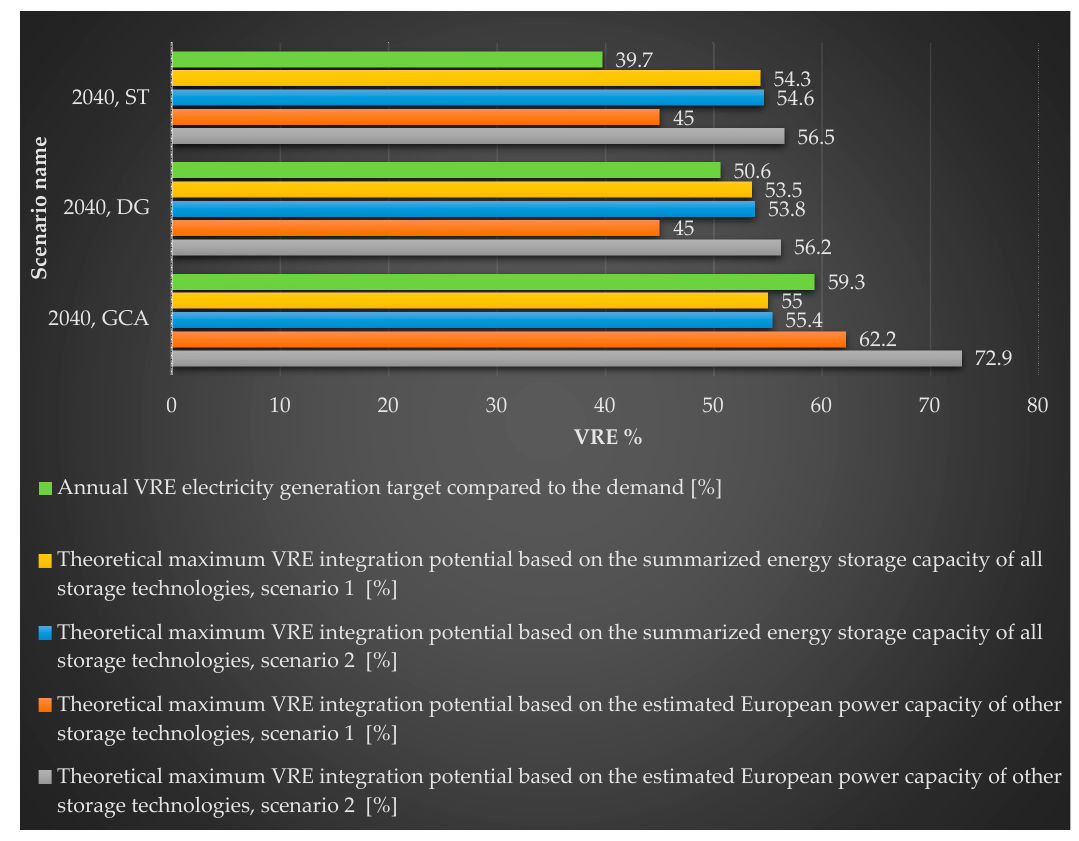
Figure 9. The feasibility of the European VRE integration target based on the various scenarios.